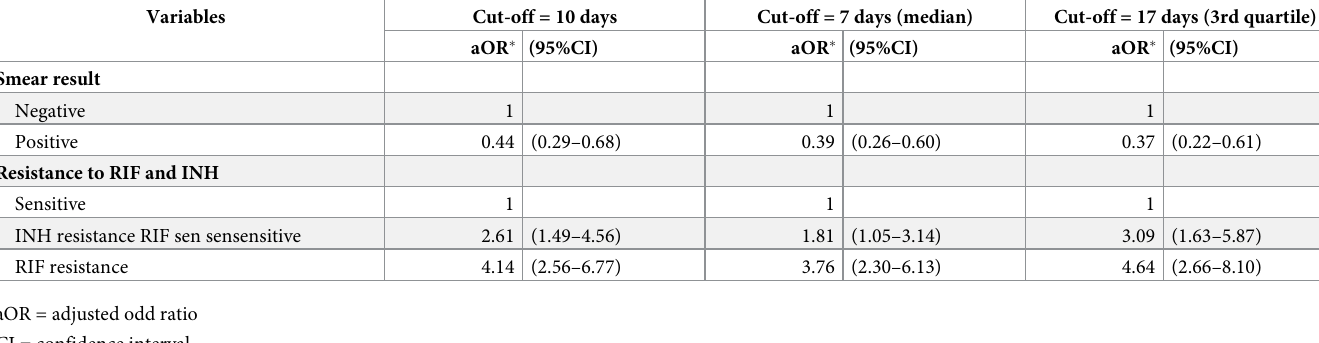
Table 3. Significant variables in sensitivity analyses for treatment delays using different cut-off